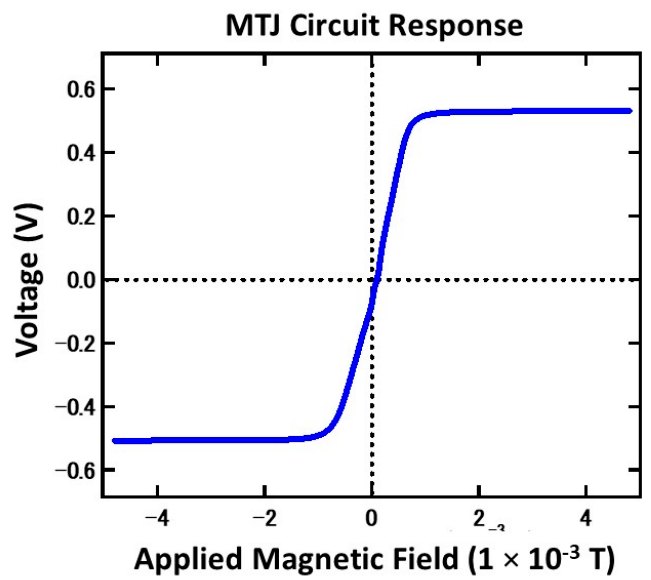
Figure 3. MTJ bridge circuit response towards an applied magnetic field inside a magnetic shield room.